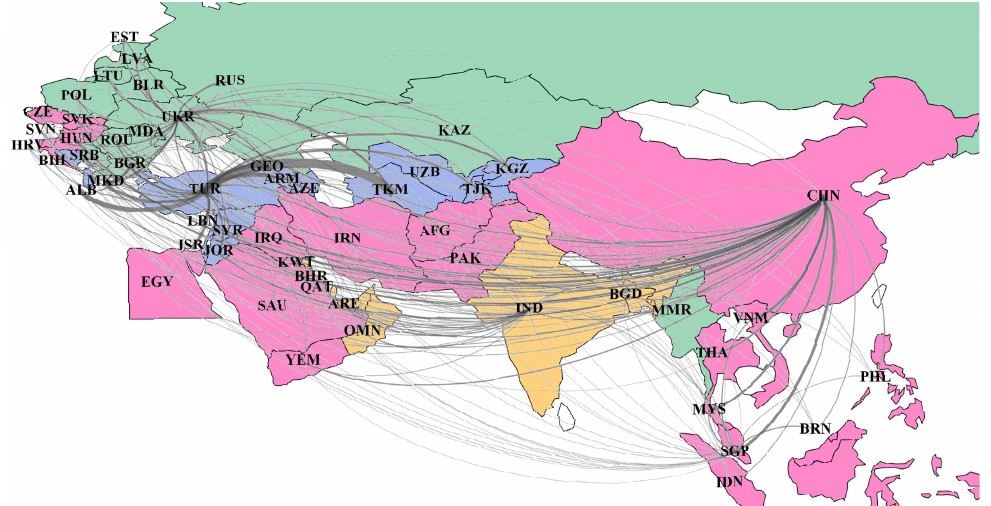
Figure 7. Communities of the EGSR transmission